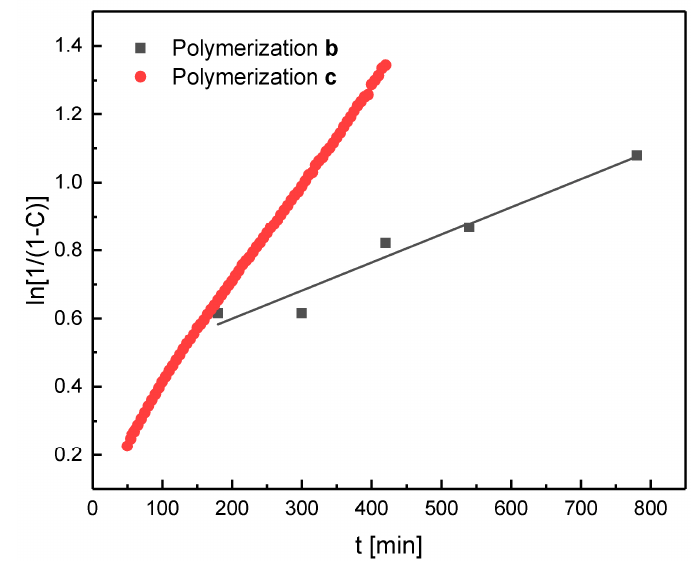
Figure 5. Polymerization method b and c with C2 at 140 °C, 400 rpm. b = 1000:1, technical rac -lactide. c = 1000:1:10, recrystallized rac -lactide.